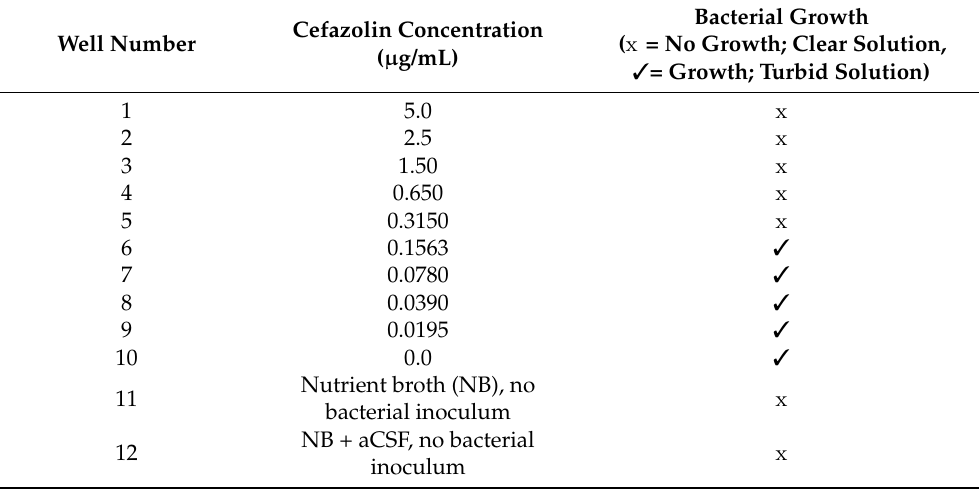
Table 3. Minimum inhibitory concentration (MIC) value of cefazolin against S. aureus ATCC 50923. Cefazolin Well Number